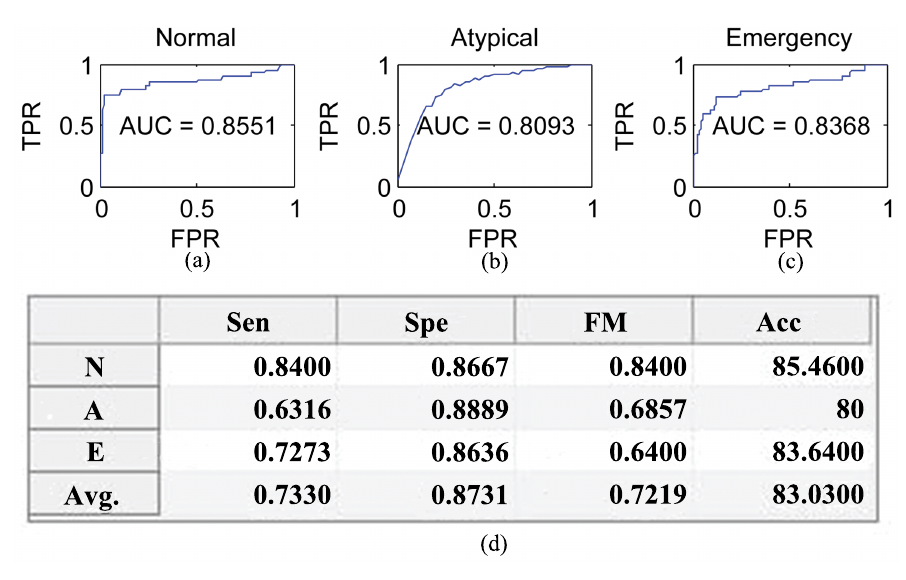
Figure 15. Area under the ROC curve of: ( a ) Normal, ( b ) Atypical and ( c ) Emergency psychiatric states; ( d ) The grid of sensitivity, specificity, F-measure and accuracy of different psychiatric states based on the testing dataset [36].